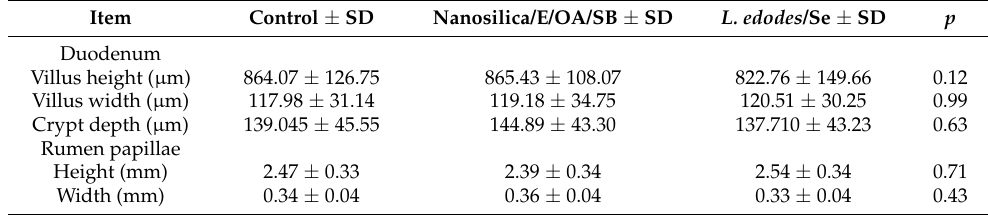
Table 8. Effect of nanosilica/E/OA/SB and L. edodes /Se on the morphometric indicators of the duodenum and rumen of calves at 70 days of age ( n =